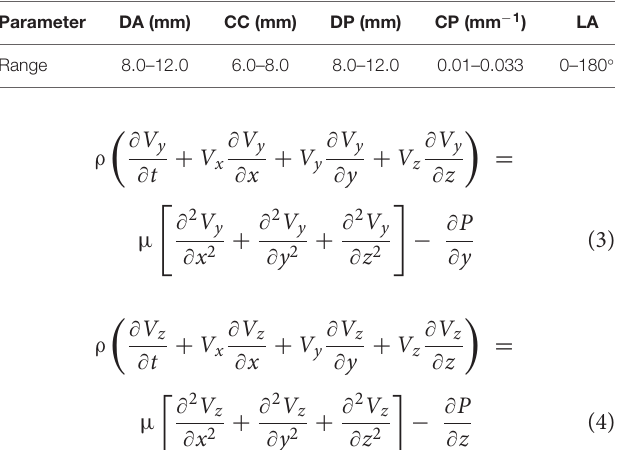
TABLE 1 | The range of morphological